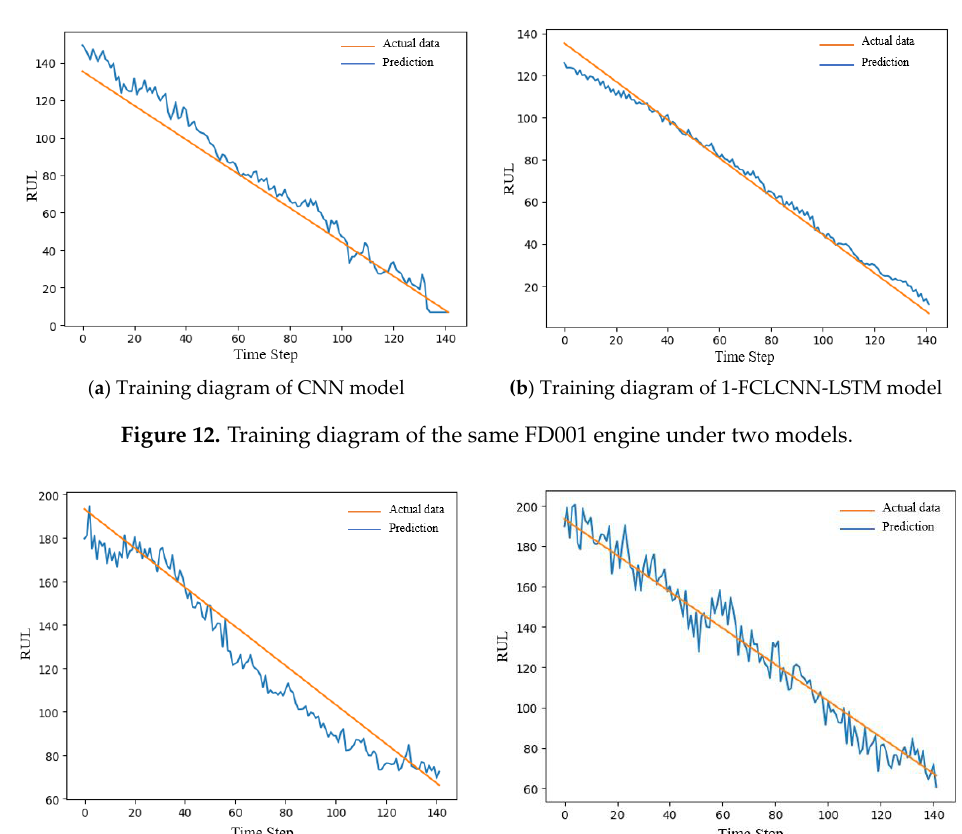
( b ) Prediction results of 1-FCLCNN-LSTM model. Figure 14. RUL prediction results of FD001 with different models.